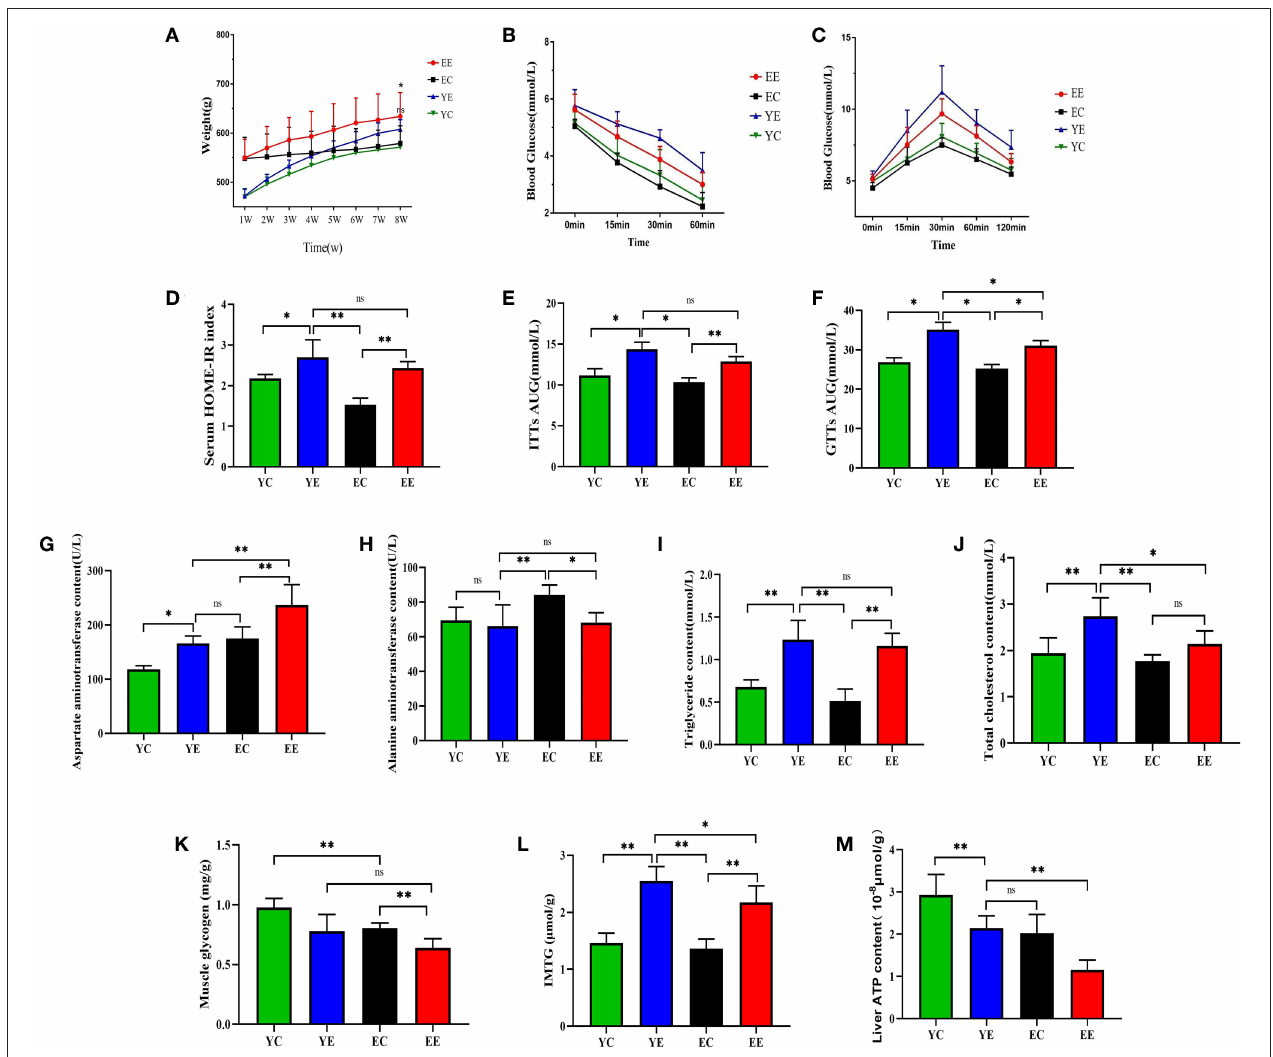
FIGURE 3 | Effect of HFD on weight, insulin sensitivity, and blood biochemistry in EE, EC, YE, and YC rats. (A) The change in body weight every week. (B) ITTs. (C) GTTs. (D) HOMA-IR. (E) ITTs-AUC. (F) GTTs-AUC. (G) Effects of HFD by intervention on the plasma AST, (H) ALT, (I) TC, and (J) CHOL in rats. (K) Muscle glycogen. (L) IMTG. (M) Liver ATP content. * p < 0.05, ** p < 0.01, ns p >